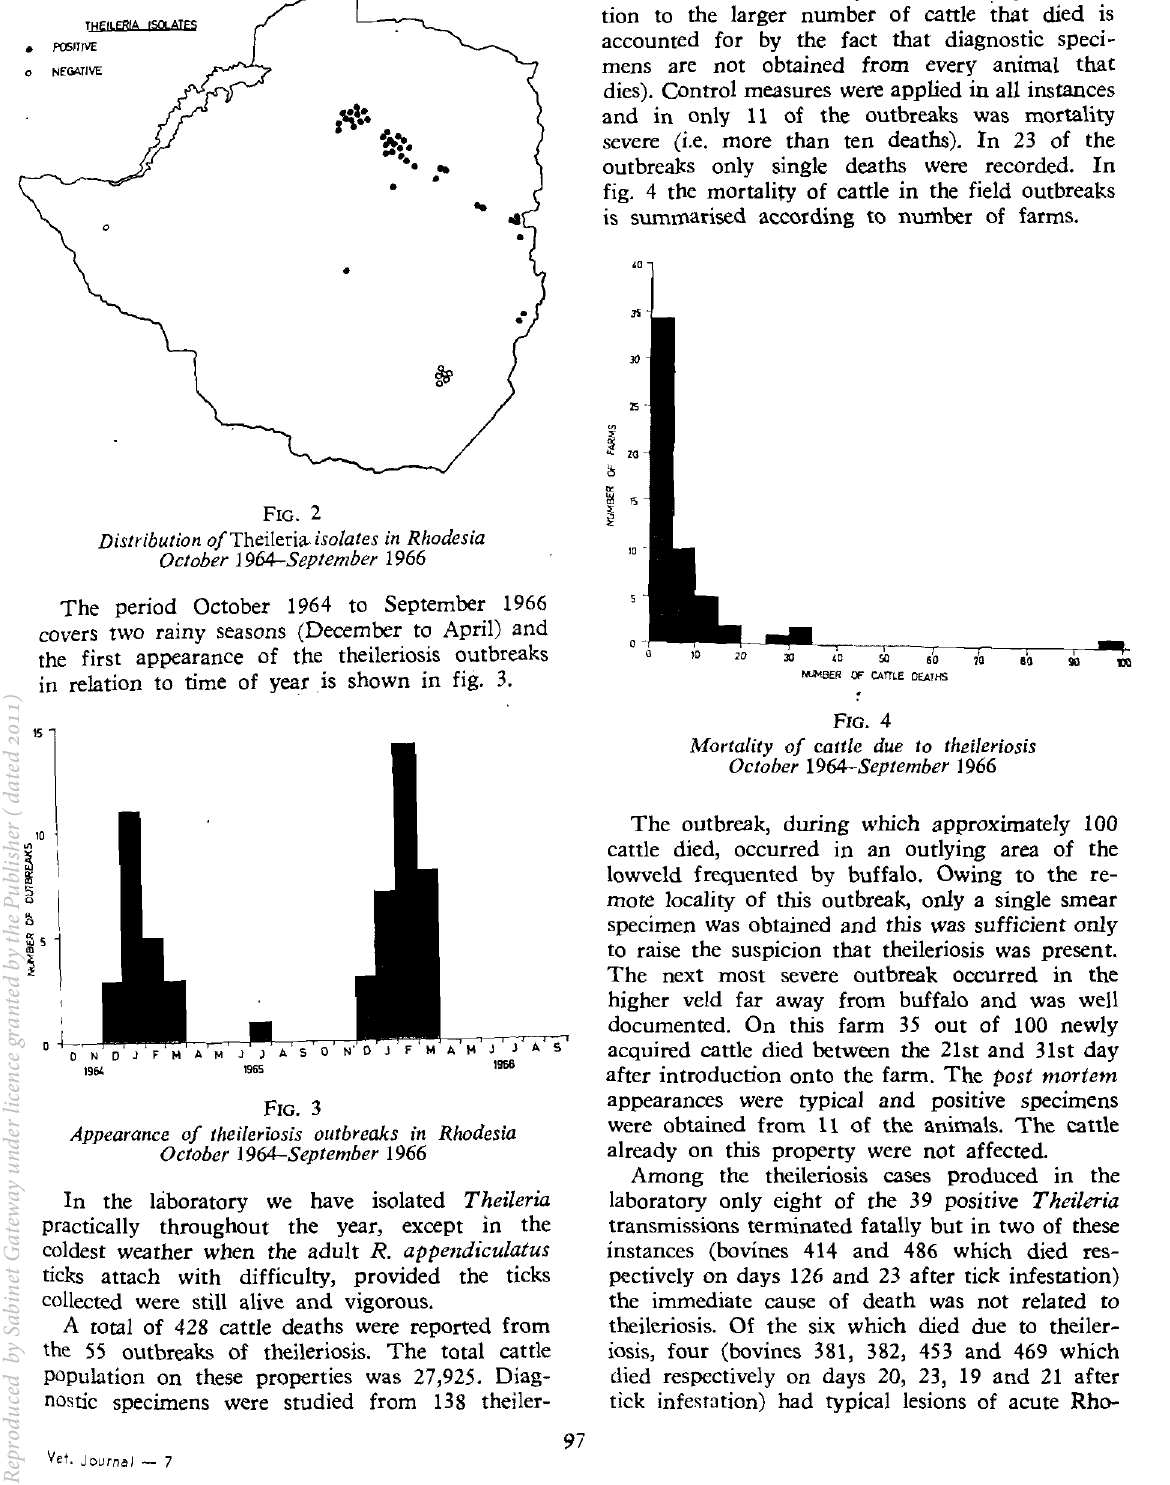
Mortality of cattle due to theileriosis October 1964-September